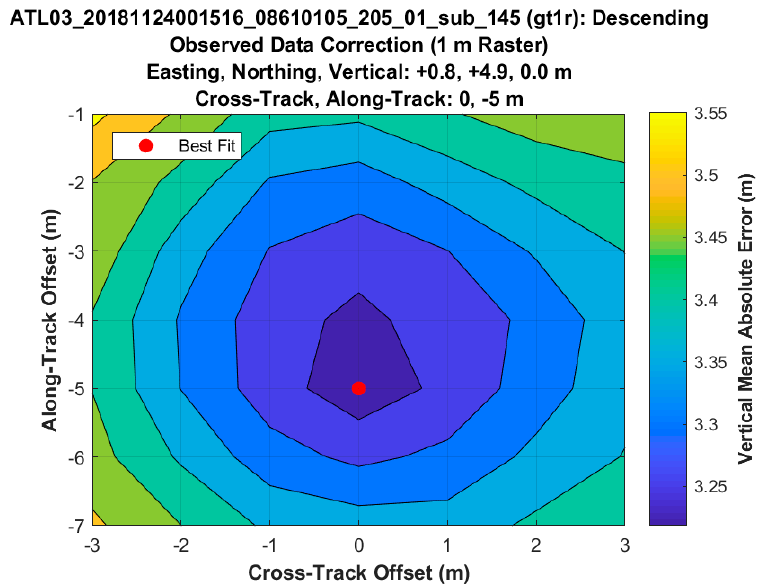
Figure 8. Geolocation accuracy plot indicating the absolute accuracy of the ICEsat-2 data compared to an airborne lidar survey from Finland.